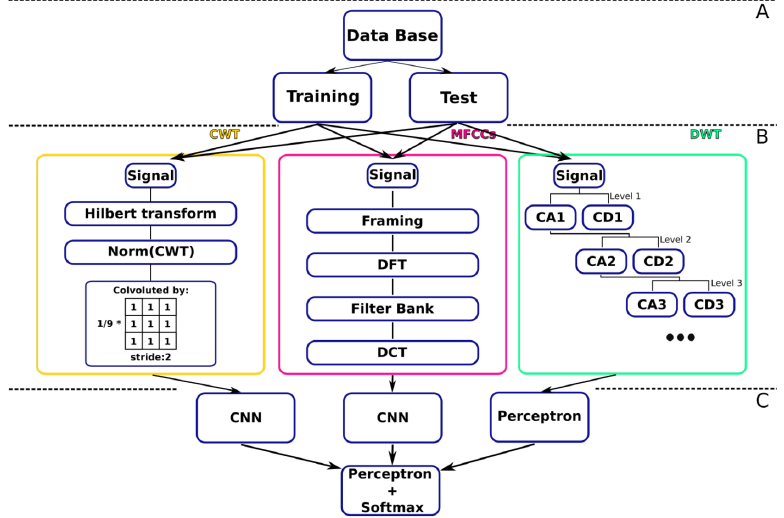
Figure 7. Block diagram for DNN: This image displays the suggested architecture. The dataset is divided into training and test sets, as shown in ( A ). Techniques for feature extraction ( B ). Algorithms for classification ( C ).